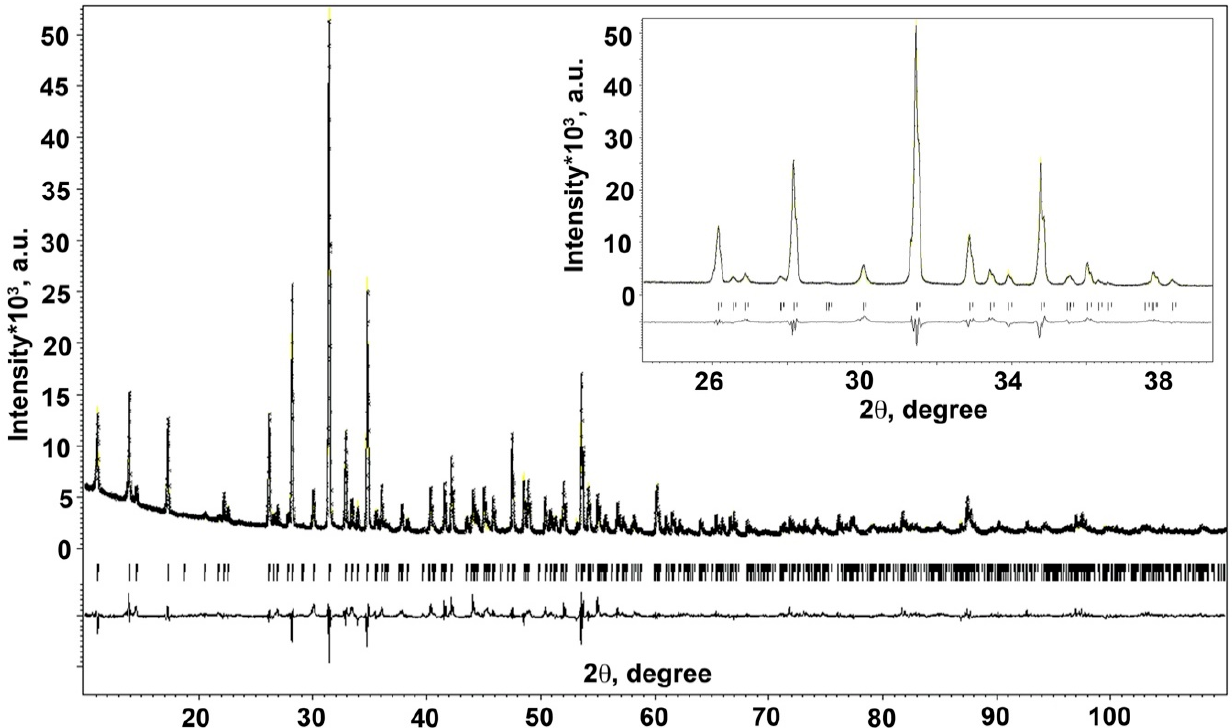
Figure 4. Fragment of observed, calculated and difference PXRD data for Ca 8 ZnGd(PO 4 ) 7 . Tick marks denote the peak positions of possible Bragg reflections. The inset shows detailed fragment of PXRD data for 2 θ = 24–40°. Table 2. Crystallographic data for Ca 8 ZnGd(PO 4 ) 7 (SG R 3 ̅ c , Z = 6, T = 293 K).